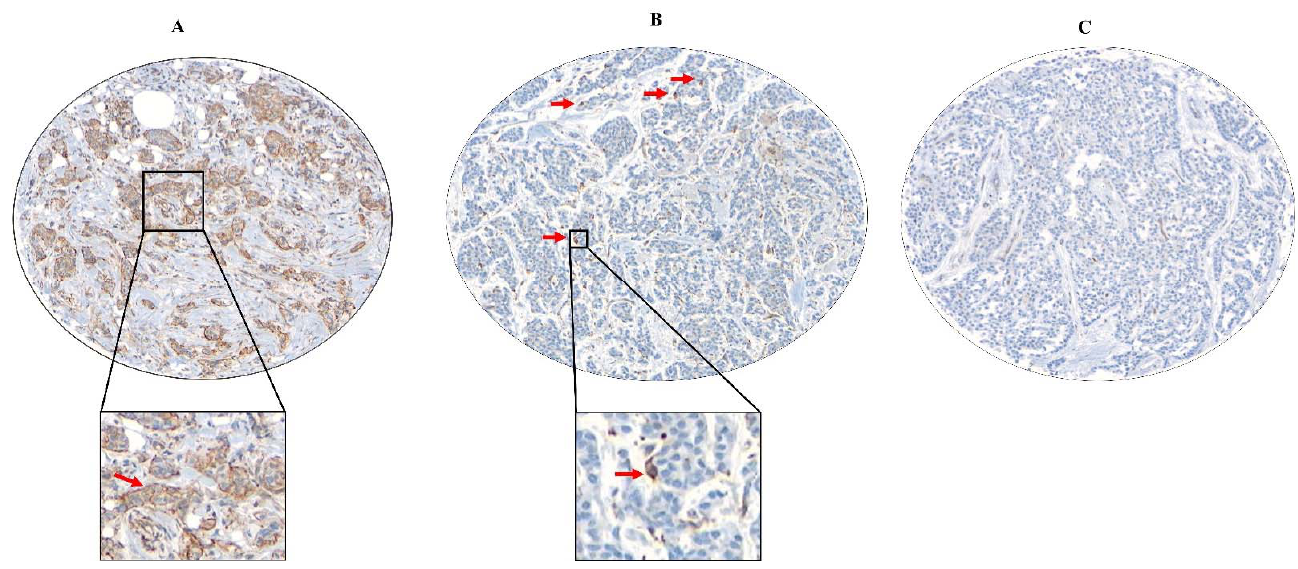
Figure 1. Representative photomicrographs for immunohistochemical staining of CSF-1R expression in breast carcinoma tissue microarray cores. ( A ) Cytoplasmic/membranous expression of high CSF-1R showing ≥ 10% positivity on carcinoma cells; ( B ) cytoplasmic/membranous expression of CSF-1R on tumor-associated macrophages (red arrows) showing ≥ 2 positive macrophages; ( C ) negative expression on tumor cells and macrophages (images acquired at 10×). The inserts show CSF-1R+ carcinoma cells ( A ) and CSF-1R+ tumor-associated macrophages ( B ) at high magnification.